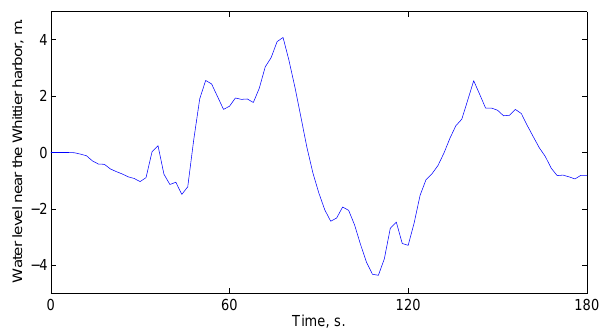
Fig. 8. Modeled height of the seiche wave near the Whittier harbor, Case 1. The drawdown of water occurs after 10s, at the moment of the maximum lateral land velocity u g , see Fig.